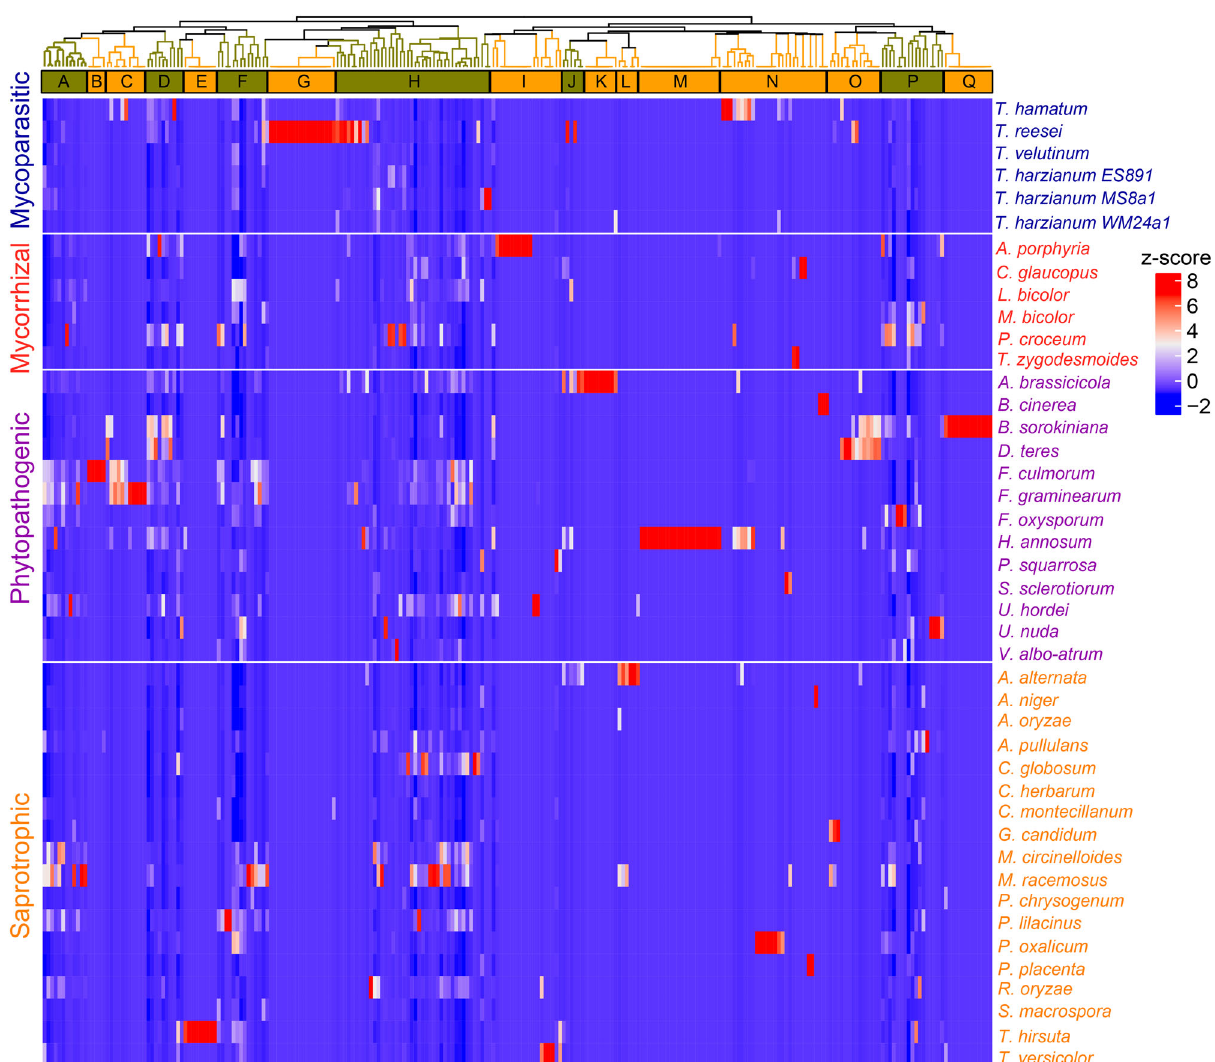
Fig. 1 Heatmap of fungal volatile organic compounds (fVOC) emission pro fi les from the examined 43 fungal species. The dendrogram shows the hierarchical clustering based on Spearman correlations ( ρ < 0.05). Compounds are grouped to 17 clusters (letters A-to-Q). The letters refer to the groupings in the Supplementary Tables S2 and S3 51 . The emission rates (ncps cm − 2 s − 1 and pmol cm − 2 h − 1 ) based on PTR – MS and GC – MS data, respectively, are color-coded: red indicates high and blue indicates low